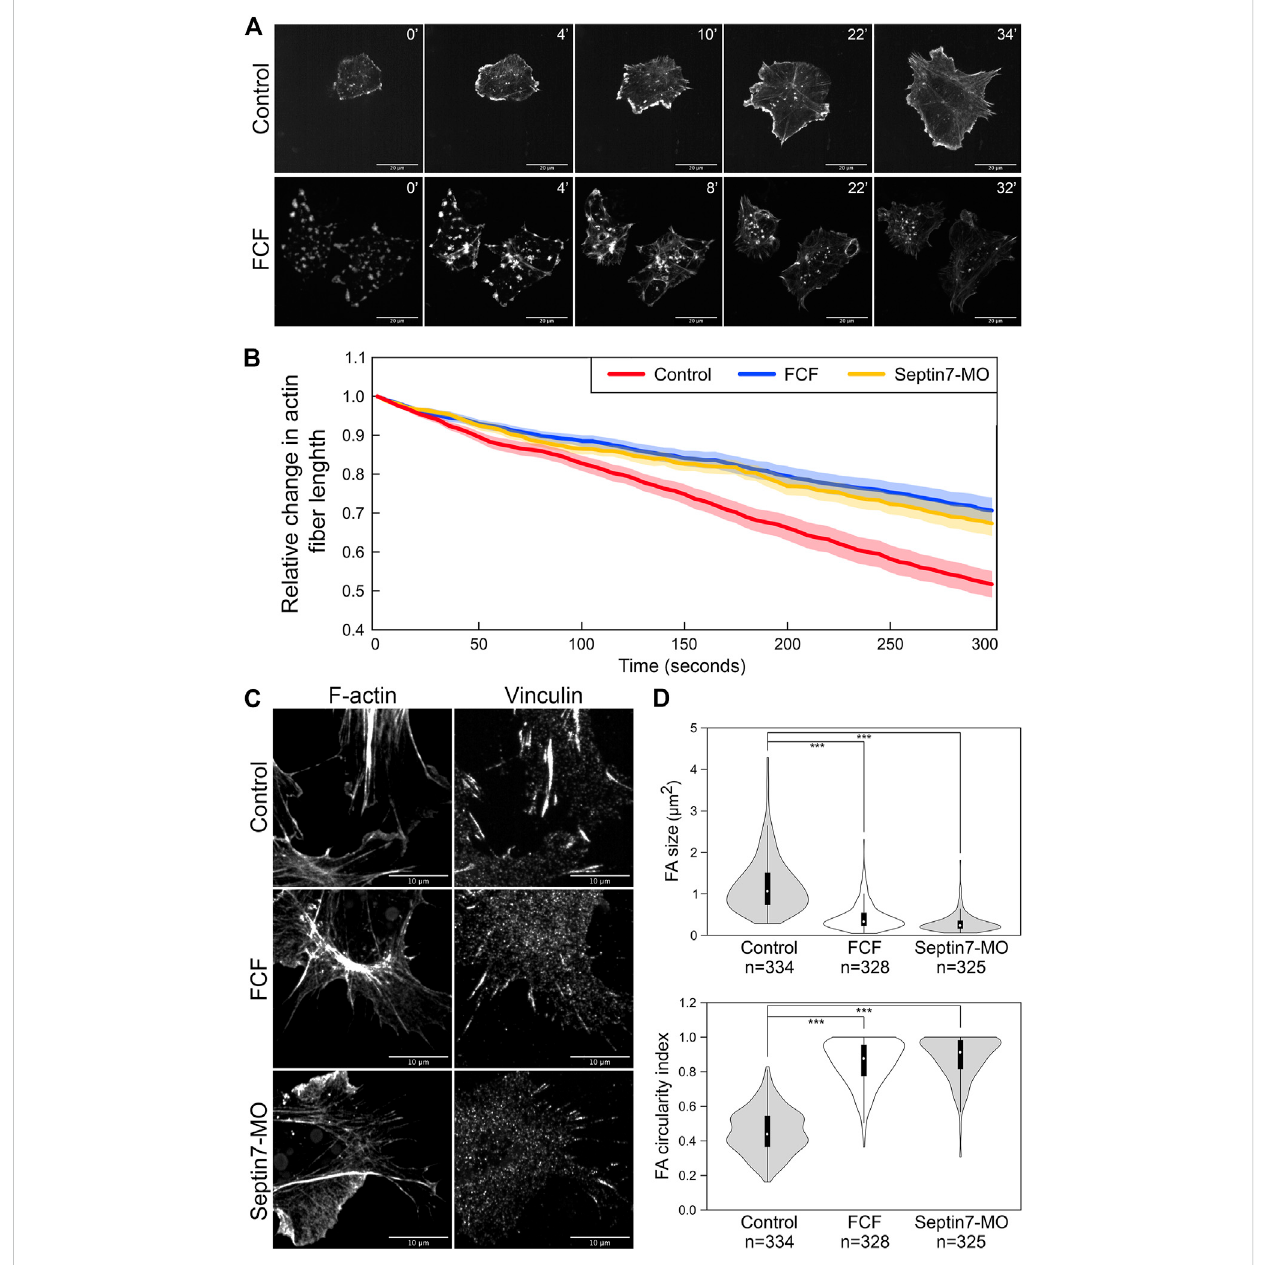
FIGURE 3 Septin fi laments regulate the stability and contractility of actin stress fi bers. (A) Recovery of actin stress fi ber in ethanol and FCF treated neural crest cells.Actinstress fi berswereremovedinneuralcrestcellsbyLatrunculinAtreatmentandtheirreassemblywasdocumentedbytime-lapseimaging.While actin stress fi bers were reassembled in FCF-treated cells, they tended to disappear over time. Scale bar = 20 µm. (B) The contractility of actin fi bers was quanti fi ed by measuring the dynamic change of their lengths. The relative changes in the length of 20 actin stress fi bers per condition were plotted. Both Septin7-MO and FCF treatment signi fi cantly decreased the speed of actin stress fi ber shortening (Student ’ s t -test, p < 0.001). Average ± standard error of the mean was plotted by the shaded area. (C) Septin inhibition disrupted the formation of focal adhesions. Separate images of focal adhesion (immuno fl uorescence againstVinculin) and actin fi laments (phalloidin) were shown. Scale bar = 10 µm. (D) Analysis of focal adhesion size and circularity. Onlythoseassociatedwithactin fi berswereanalyzed.Bothmethodsofseptininhibitionreducedfocaladhesionsizeandelongationsigni fi cantly.***, p <